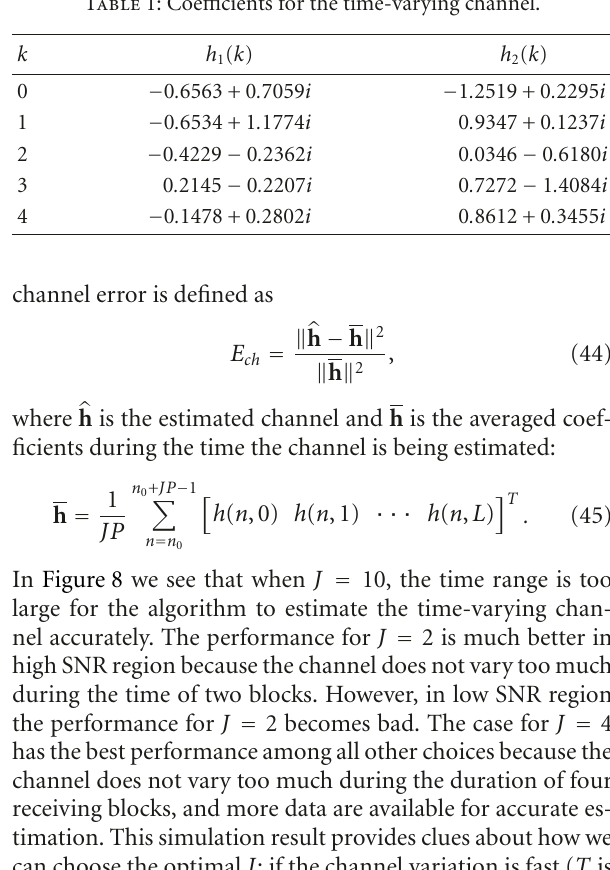
Table 1: Coe ffi cients for the time-varying channel.